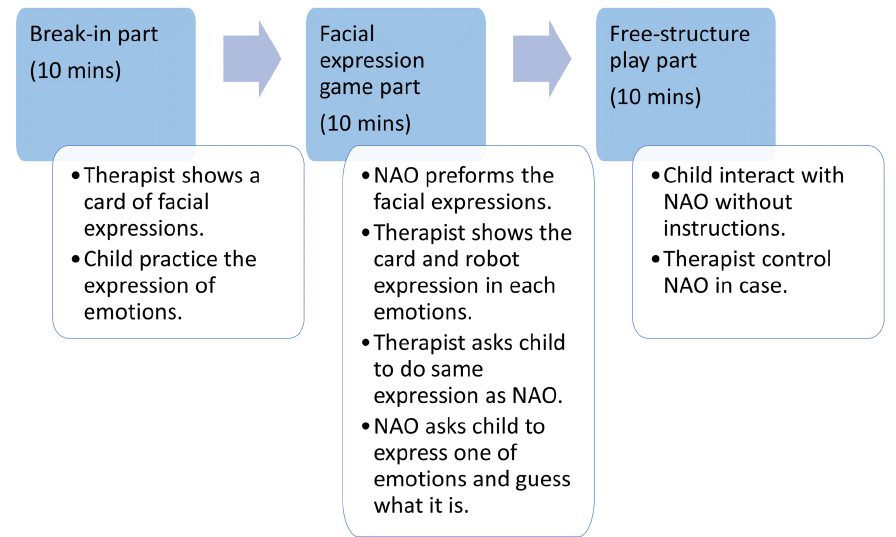
Figure 1. The procedure of the interaction between child and NAO